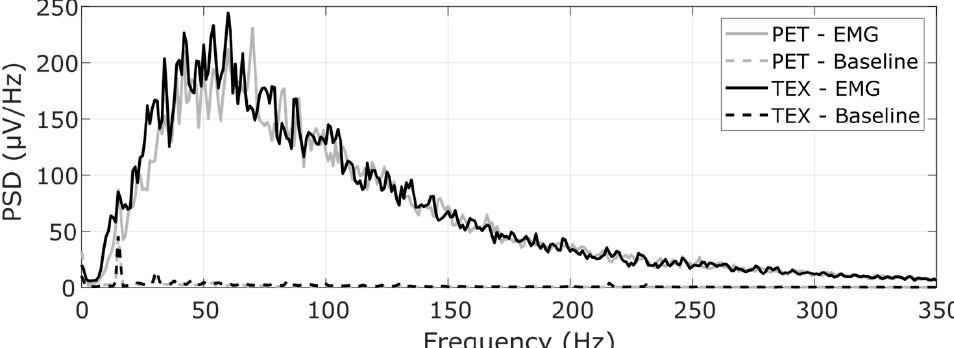
Figure 11. Mean power spectral density of the EMG recorded from a representative participant. Solid lines correspond to the mean PSD across channels calculated from the EMG signal recorded during muscle contractions, while the dashed lines represent the mean PSD during rest. The standard deviation was similar between interfaces and hence not shown to improve readability.